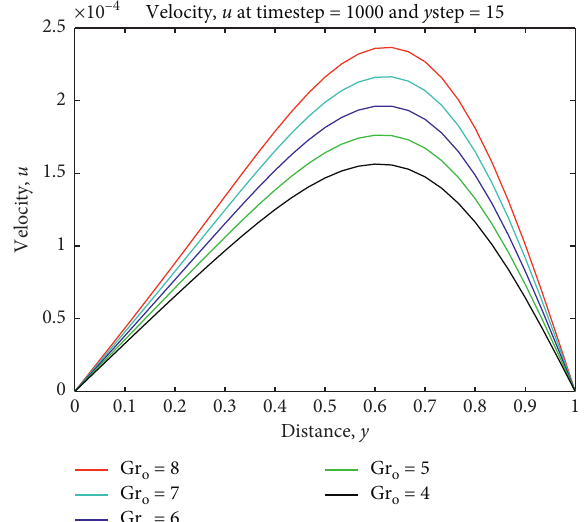
Figure 4: Effects of thermal Grashof number on primary velocity profile.